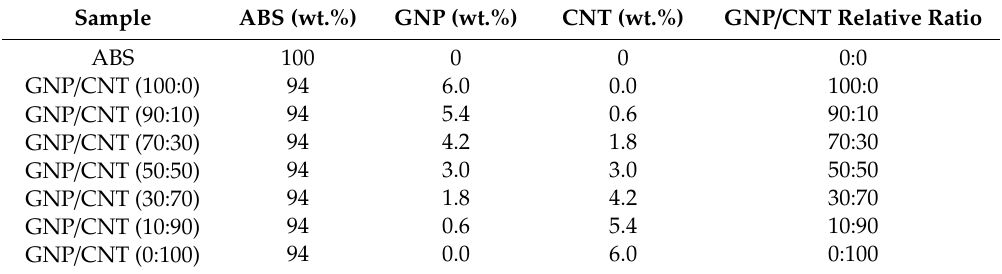
Table 2. Designation and formulation of acrylonitrile butadiene styrene (ABS) hybrid nanocomposites at different GNP/CNT ratios.